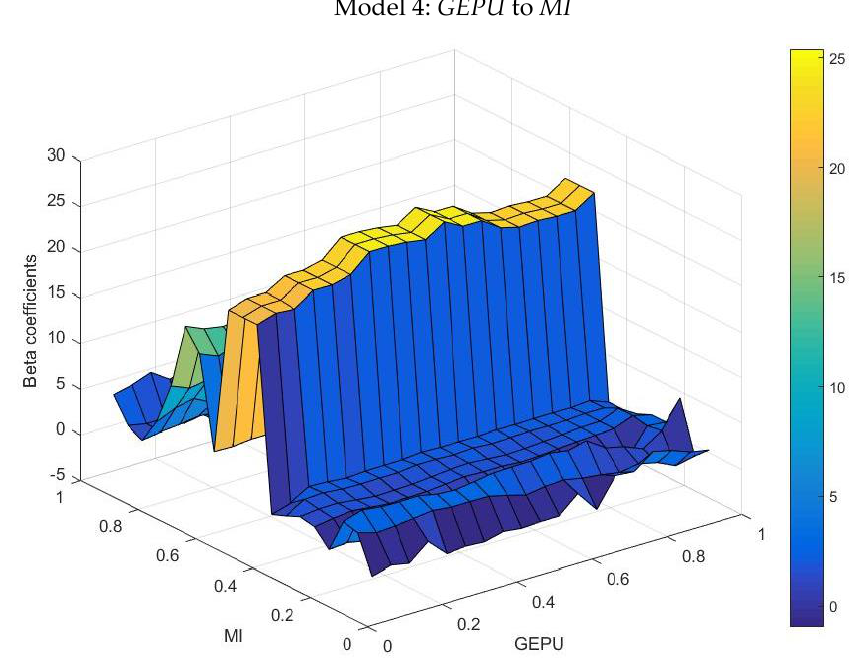
Figure 9. Global economic policy uncertainty ( GEPU ) and mineral import ( MI ). Notes: The z -axis exhibits the slope coefficients against the quantiles of MI ( θ ) on the y -axis and the quantiles of GEPU ( τ ) on the x -axis. The yellow and green colors represent the strongly positive slope coefficients, while the light blue colors display the moderately positive slope coefficients. Besides, the dark blue color reveals the trivially negative slope coefficients.